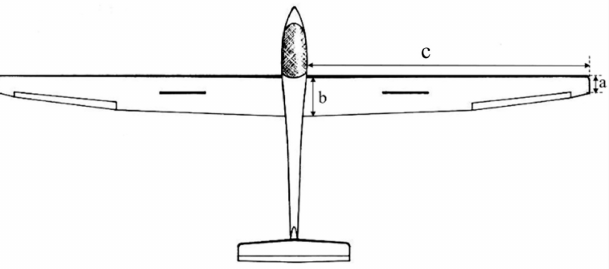
Figure 6. The sketch of the glider: a and b are the bases, c is the height of the trapezoidal